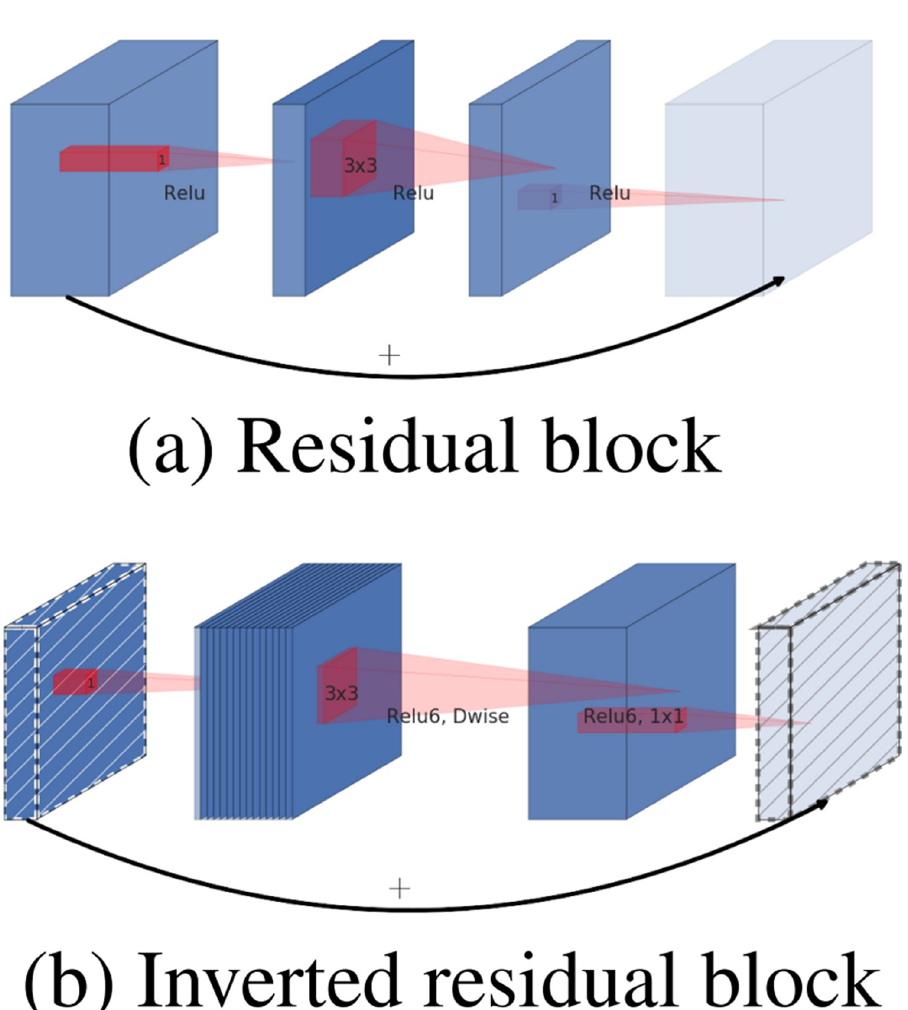
Fig 7. The difference between residual block (a) and inverted residual